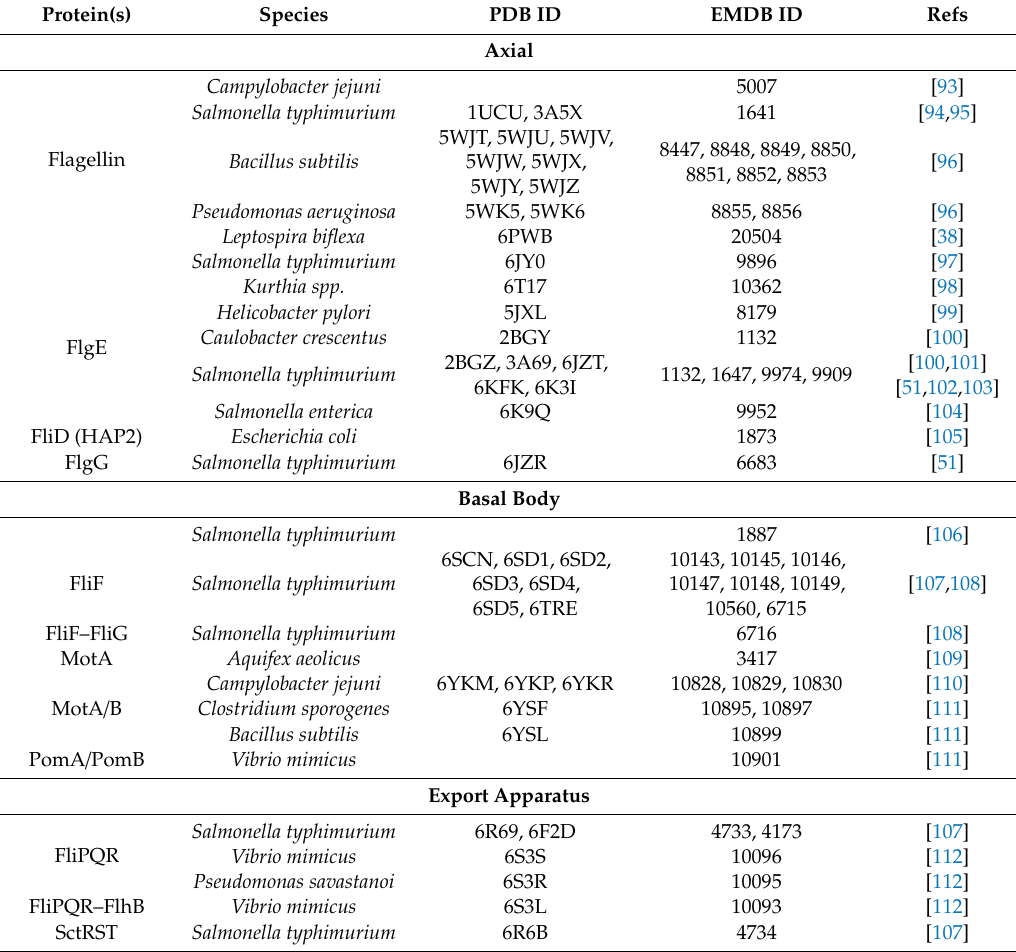
Table 2. Cryo-EM structures for flagellar subcomplexes . A list of the cryo-EM maps and models deposited in the EMDB and